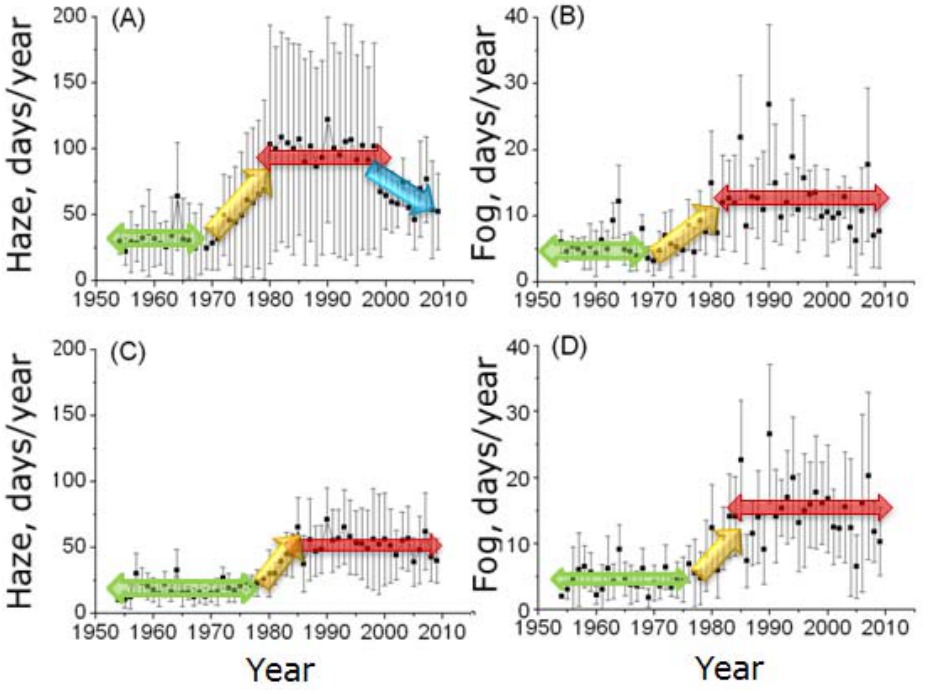
Fig. 3. Evolution of average haze day occurrences at urban sites (A) and rural sites (C) , and average fog day occurrences at urban sites (B) and rural sites (D) over the NCP region, the bars is standard deviation.